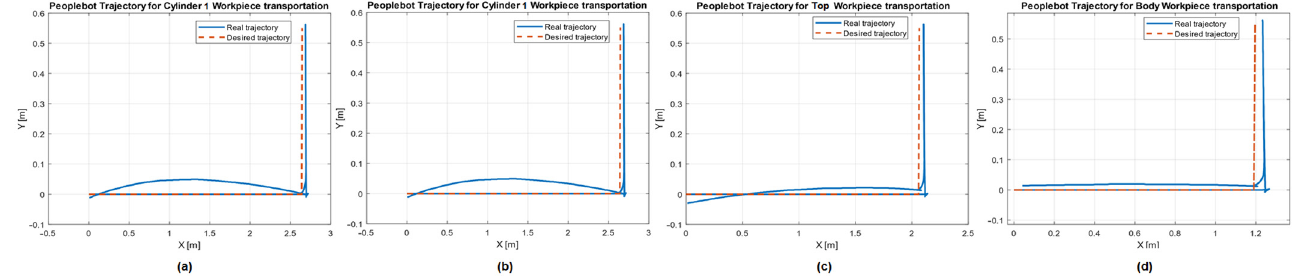
Figure 29. Full disassembly process. Desired and real trajectories of ARS PeopleBot based on TTSMC: ( a ) Cylinder 1, ( b ) Cylinder 2, ( c ) Top and ( d ) Body.